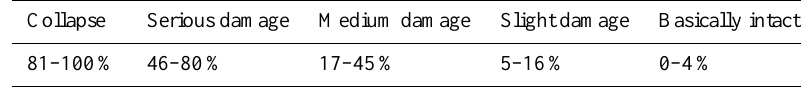
Table 2. Industrial factory building damage loss ratio.